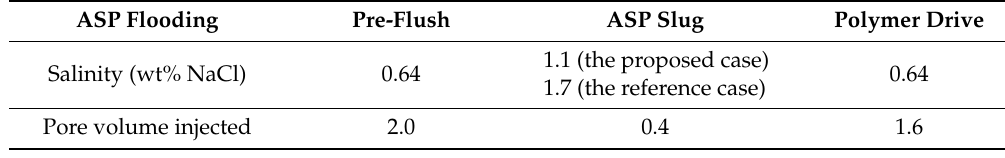
Table 5. Detailed design of the coreflooding test (ASP flooding).